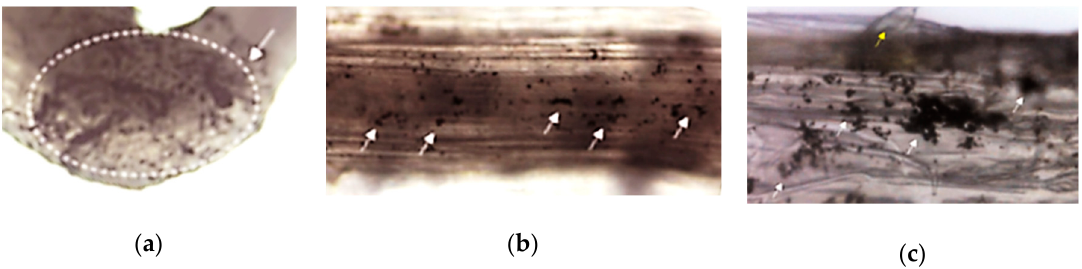
Figure 33. Bright-field micrographs illustrating ( a ) root apex of Lepidium sativum and ( b ) and ( c ) root longitudinal sections of ( b ) Sinapis alba and ( c ) Sorghum saccharatum treated with 992 mg/L of n Fe for 72 h at 25 °C. White arrows indicate n Fe aggregates, while yellow one shows root hairs. (modified after [64] ).